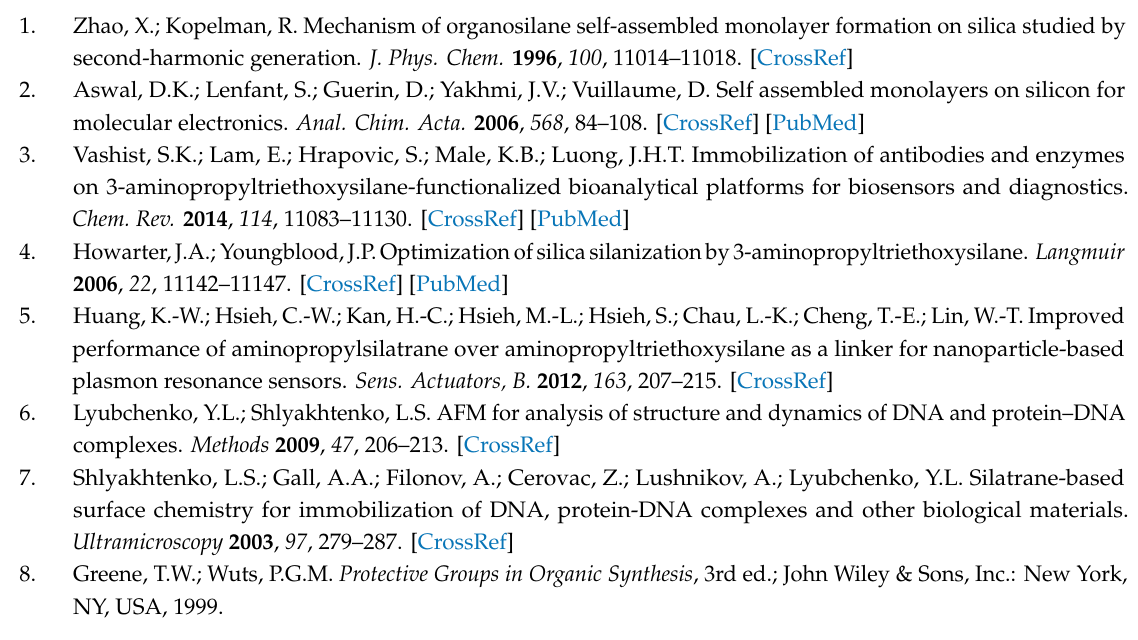
Figure S1: 1H NMR spectra of BocAPS, CDCl 3 ; Figure S2: 13C NMR spectra of BocAPS, CDCl 3 ; Figure S3: 1H NMR spectra of BocAPS ( a ), glutaraldehyde ( c ), mixture of BocAPS and glutaraldehyde after 30 min ( b ), D 2 O; Figure S4: 1H NMR spectra of BocAPS obtained recently (green, there are residues of DMF) and after two years of storage at room conditions (blue), CDCl 3 ; Figure S5: Wettability of parts of the anode and cathode after electrochemical removal of Bocgroups; Figure S6: Survey XPS spectra of the BocAPS-modified SiO 2 surface ( a ) and BocAPS-modified SiO 2 surface with removed Boc-groups ( b ); Figure S7: The activity of glucose oxidase immobilized on silicon slides, which were modified by APTES or BocAPS and had di ff erent holding times (at room conditions) between the formation of SAM and the immobilization of the enzyme; Table S1. Selected crystallographic data and details of refinement for N-tert-butoxycarbonylaminopropyl